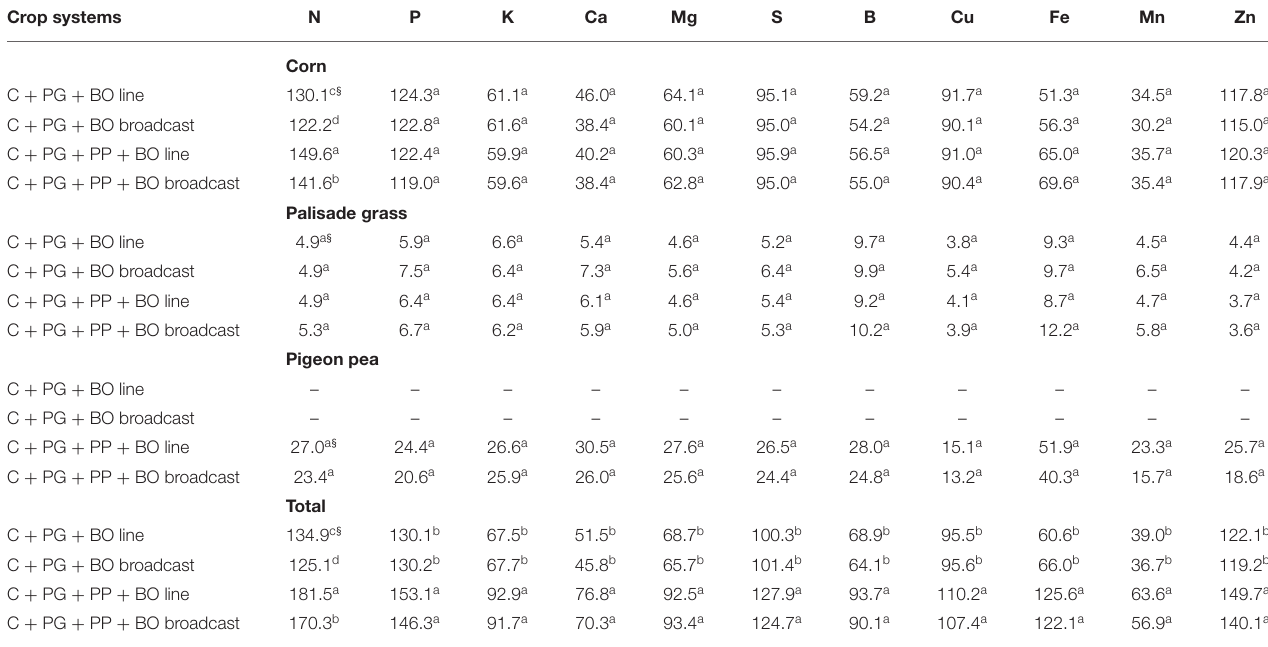
TABLE 8 | Relative nutrient yield (%) of corn to silage intercropped with palisade grass (C + PG) and with palisade grass and pigeon pea (C + PG + PP) with black oat (BO) oversown in lines and broadcast compared to corn, palisade grass, and pigeon pea monoculture (mean of three growing seasons). Crop